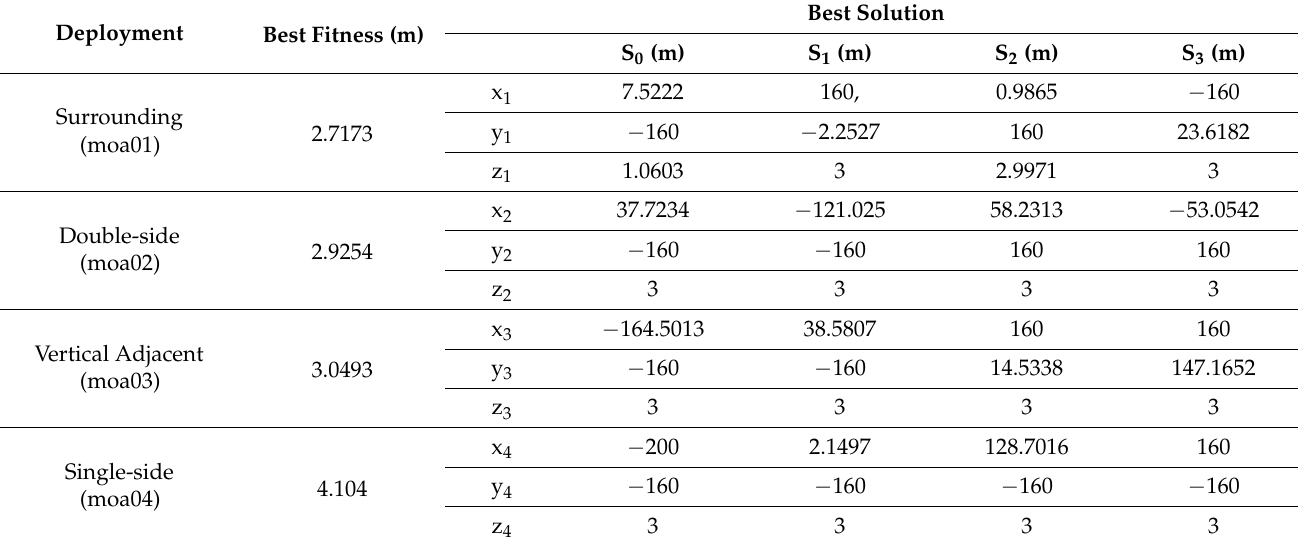
Table 2. Optimized results of the four stations deployments under scenario 2 1 .